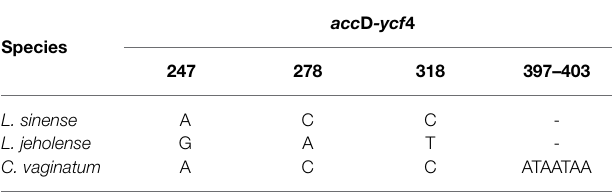
TABLE 4 | Variation of acc D -ycf 4 in L. sinense , L. jeholense , and C. vaginatum .